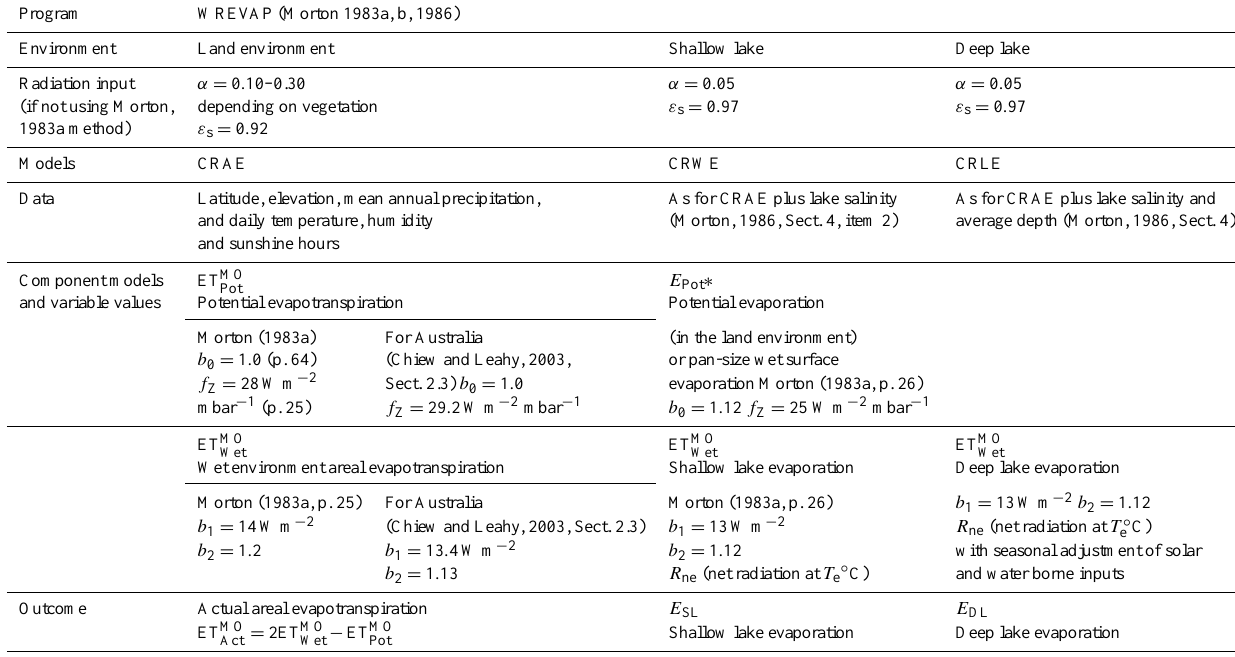
Table 2. Morton’s models ( α is albedo, ε s is surface emissivity, and b 0 , b 1 , b 2 and f Z are defined in Sect.